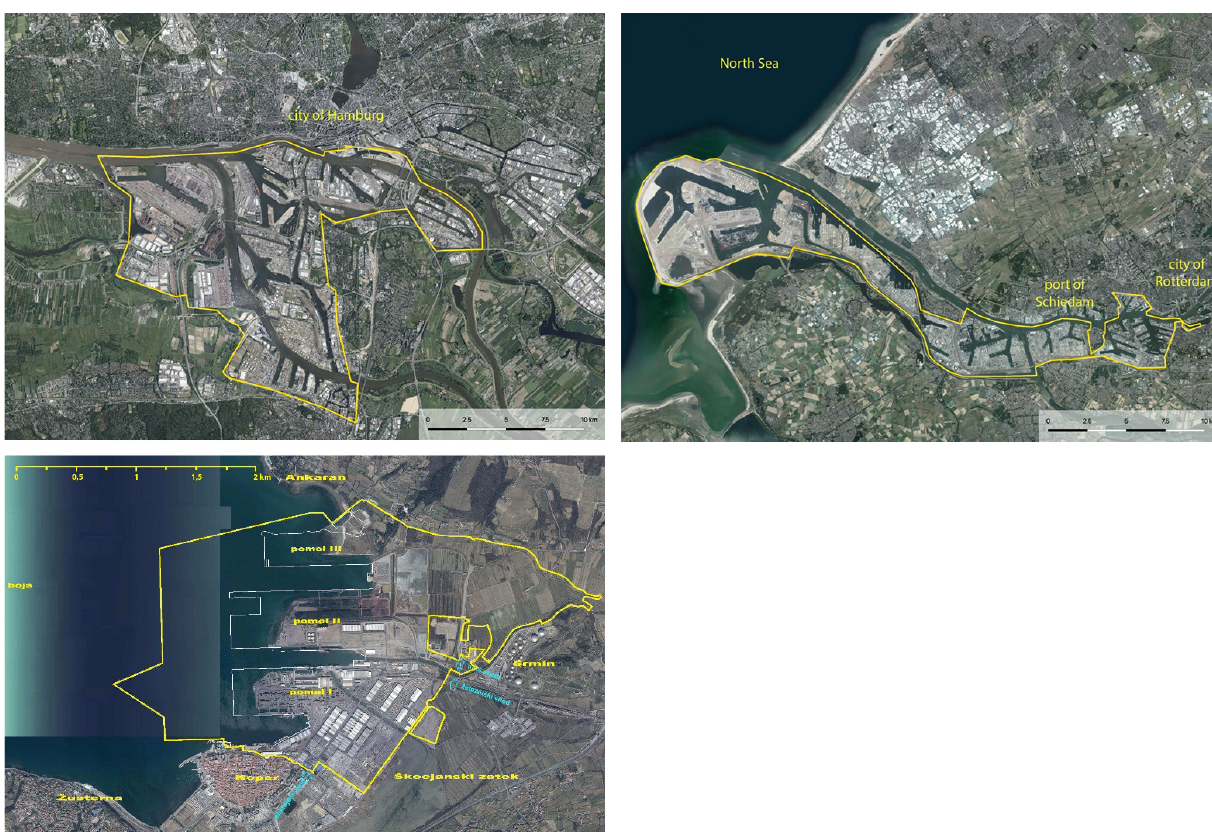
Figure 7. Sizes of the ports of Hamburg, Rotterdam, and Koper. (a) Size of the port of Hamburg in relation to the city and its surroundings. (top left); (b) size of the port of Rotterdam in relation to the city and its surroundings (top right); (c) the border of the national spatial plan for the port of Koper, 2011, which includes other land uses within the border area in the northern part (recreational areas, military zone, etc.) and in the south (bus station, etc.; bottom). Sources: ESRI Google Satellite and The Ministry of Environment and Spatial Planning of the Republic of Slovenia